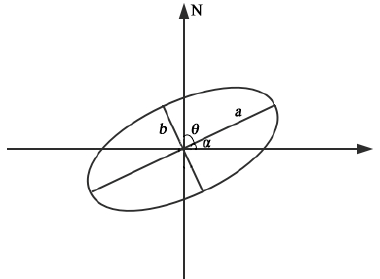
Figure 3. The schematic diagram and parameters of the standard deviation ellipse. N is the north direction, a and b is the major axis semidiameter and the minor axis semidiameter, θ is the rotation angle, and α is used to judge the distribution pattern.